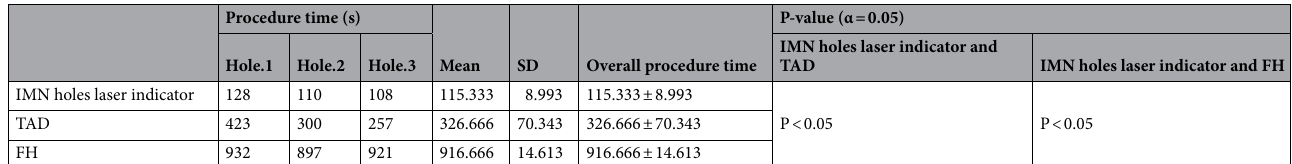
Procedure time (s)